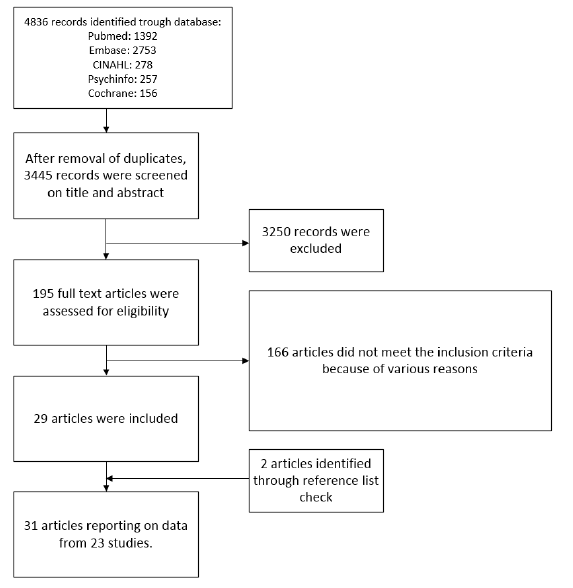
Figure 1. Flowchart depicting the search and selection